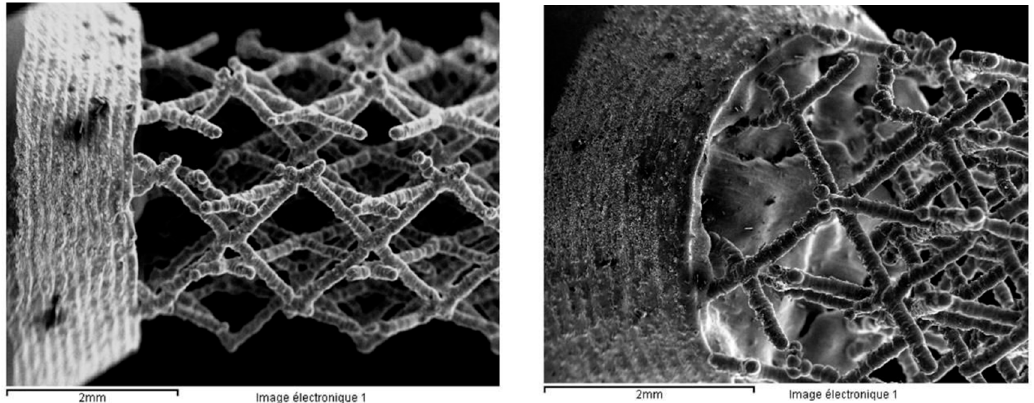
Figure 26. SEM images of the Ti6Al4V alloy sca ff old structure taken before any machining or cleaning